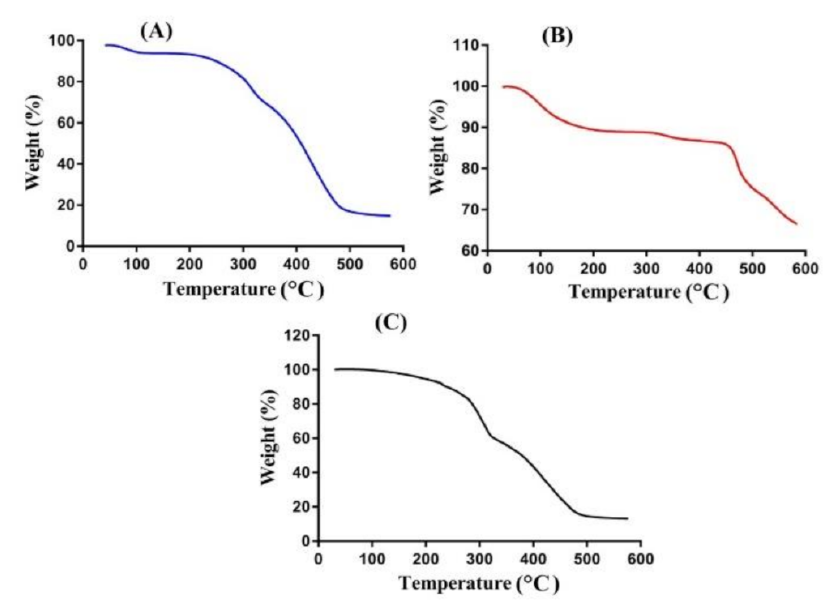
Figure 2. TGA of ( A ) CP, ( B ) SpS, and ( C ) CP/SpScPAA hydrogels.